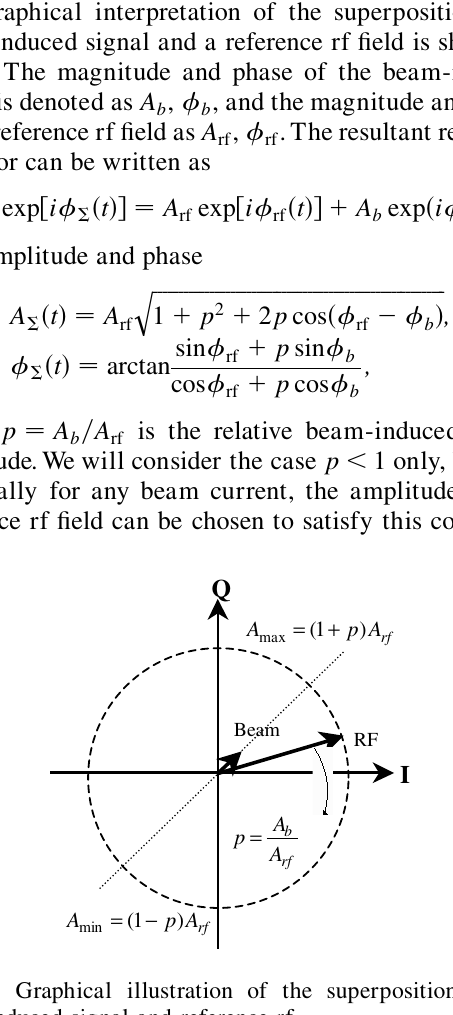
FIG. 1. Graphical illustration of the superposition of the beam-induced signal and reference rf.